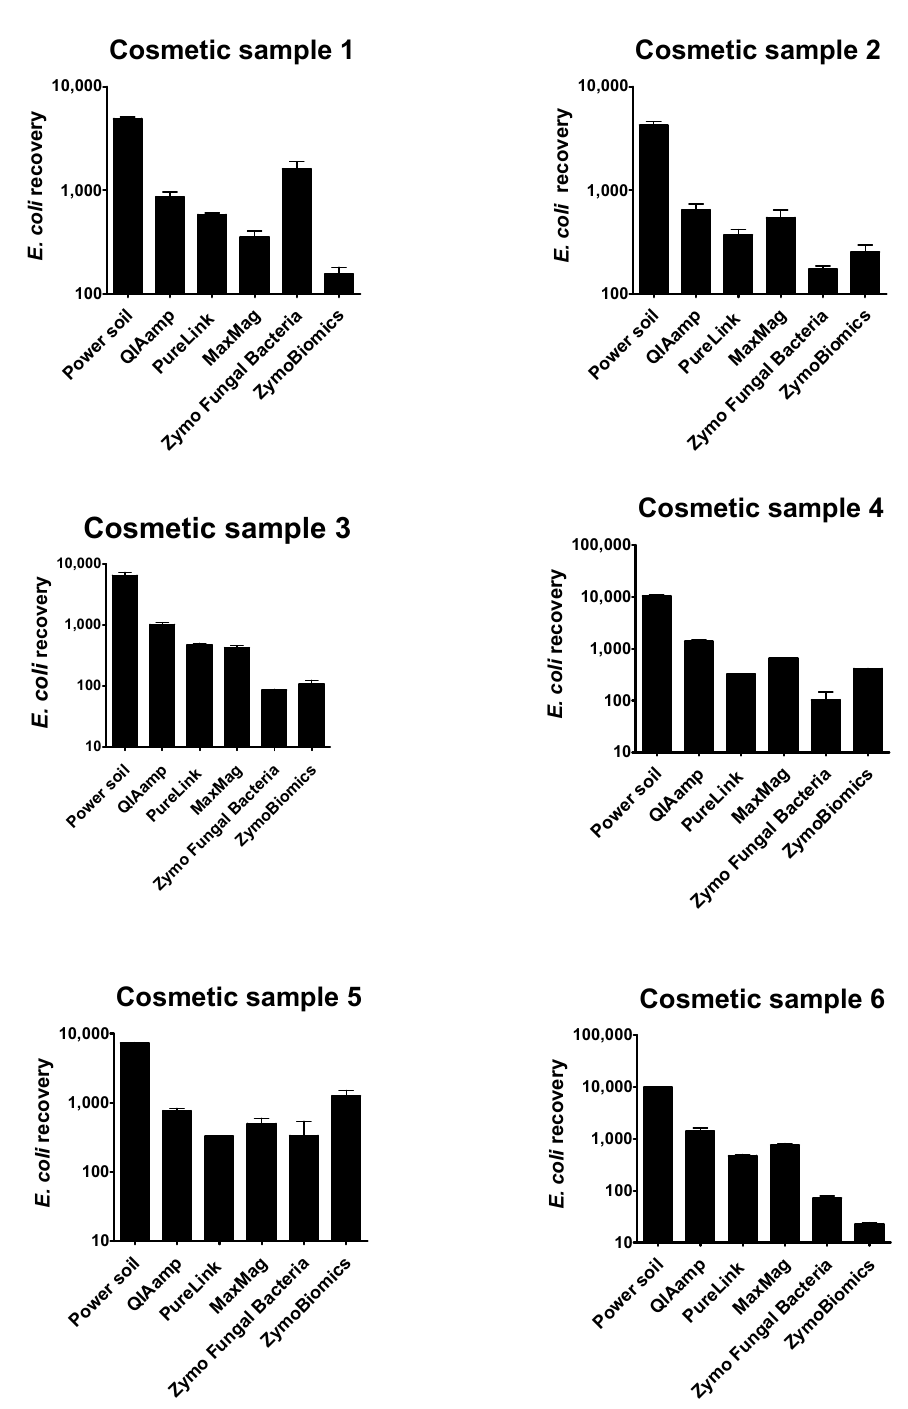
Figure 3. Histograms showing Escherichia coli recovery by qPCR. On the X axis, the name of the commercial kit employed is reported, while on the Y axis, the number of cells extrapolated from the linear regression is described.